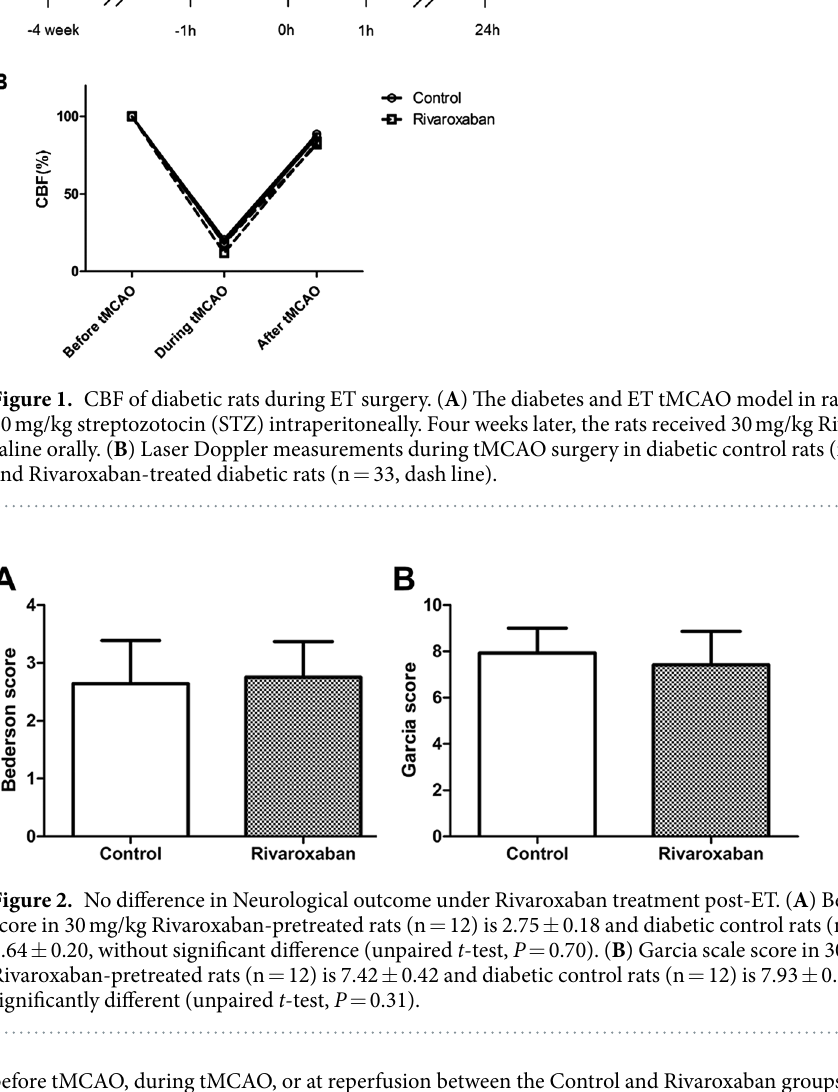
Neurological score and outcomes. The neurological score did not differ significantly in the Rivaroxaban group than the Control group (2.75 ± 0.18 versus 2.64 ± 0.20 for Bederson scale score, P = 0.70; 7.42 ± 0.42 versus 7.93 ± 0.29 for Garcia scale score, P = 0.31; Fig. 2A,B).